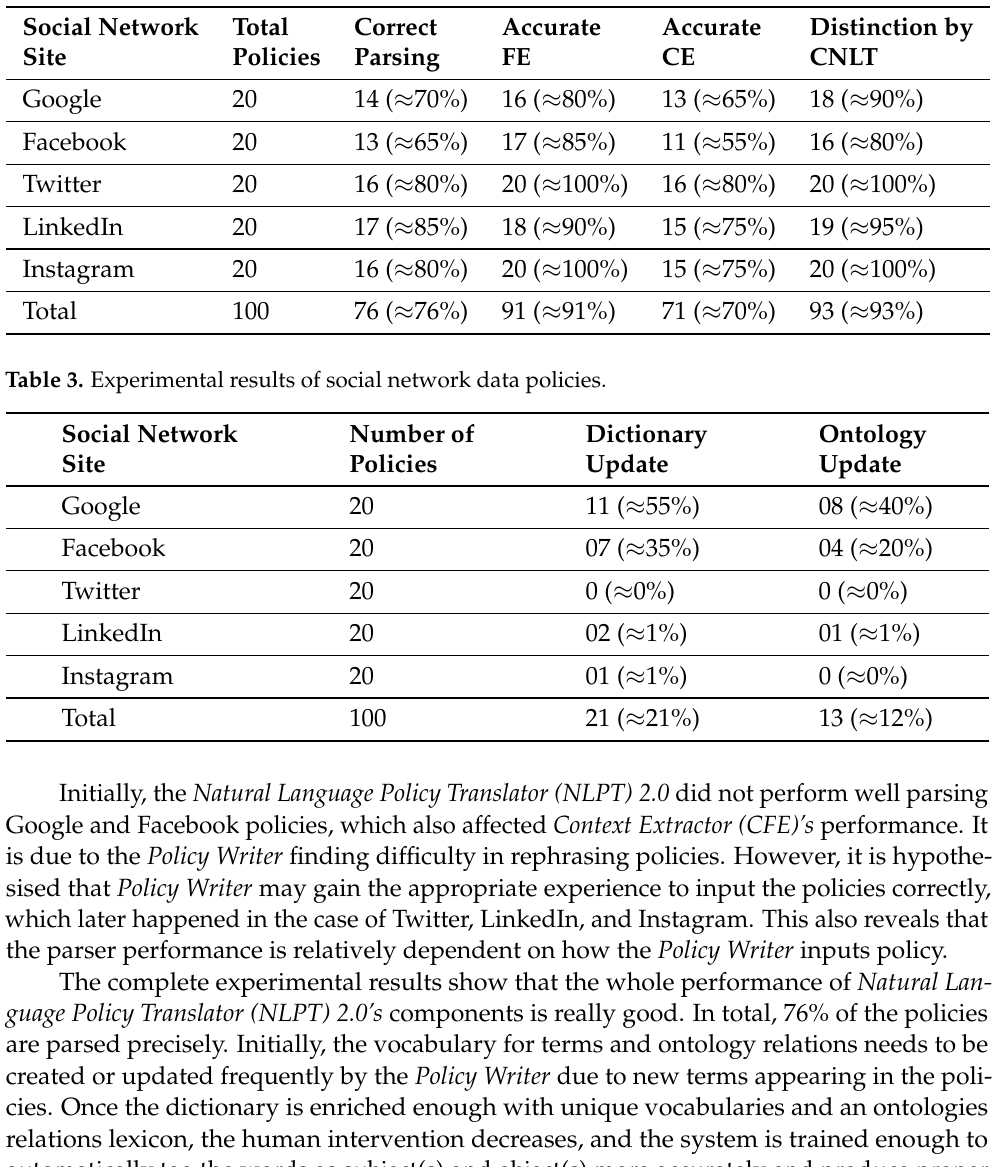
Table 2. Experiment results of social network data policies.